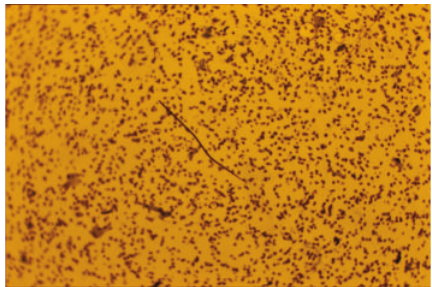
Figure 6: Microfilaria of D. repens